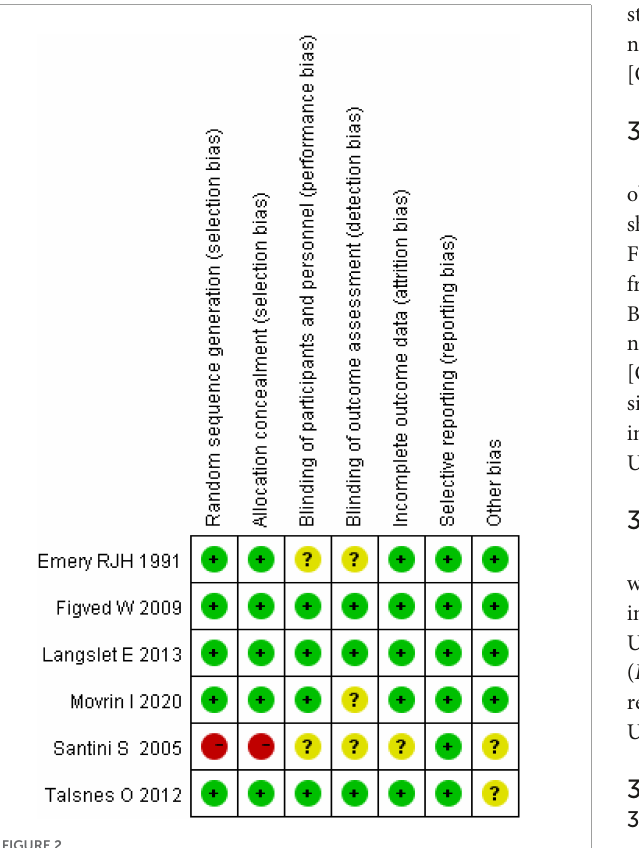
FIGURE2 Risk of bias assessment of randomized controlled trials.